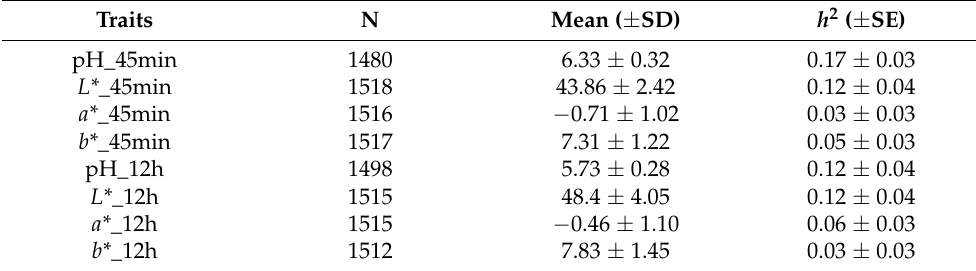
Table 1. Summary statistics of meat quality traits in DLY pigs.